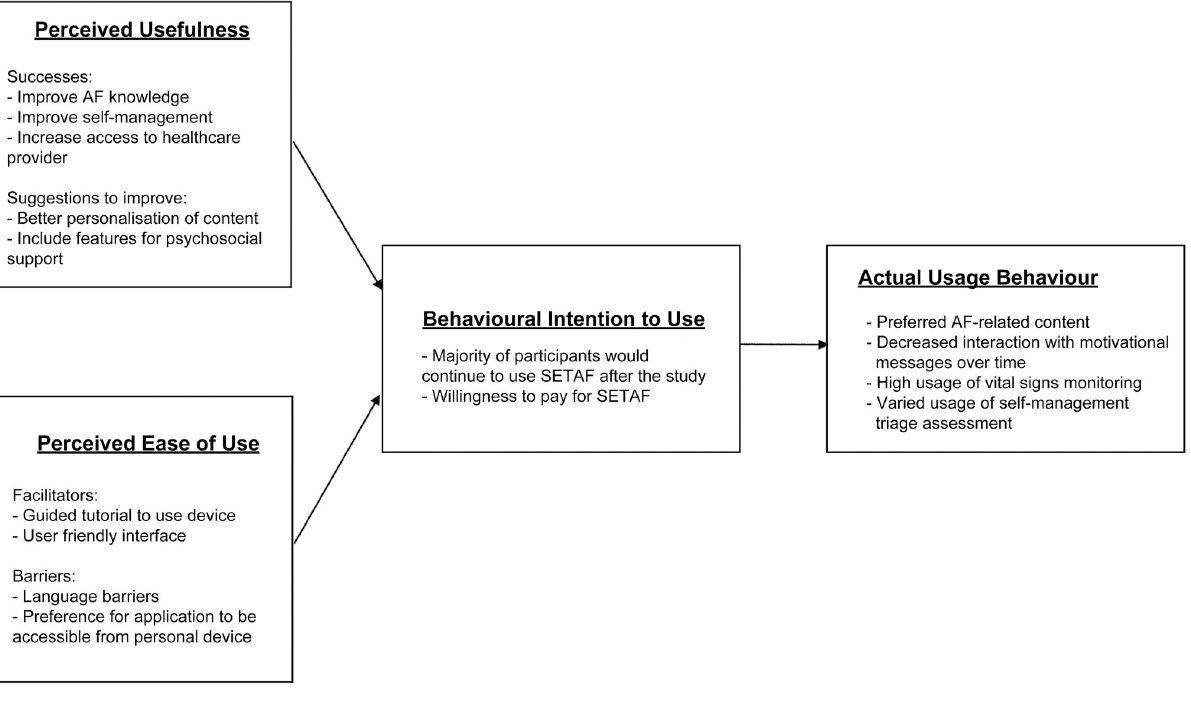
Fig 1. Technology acceptance model for